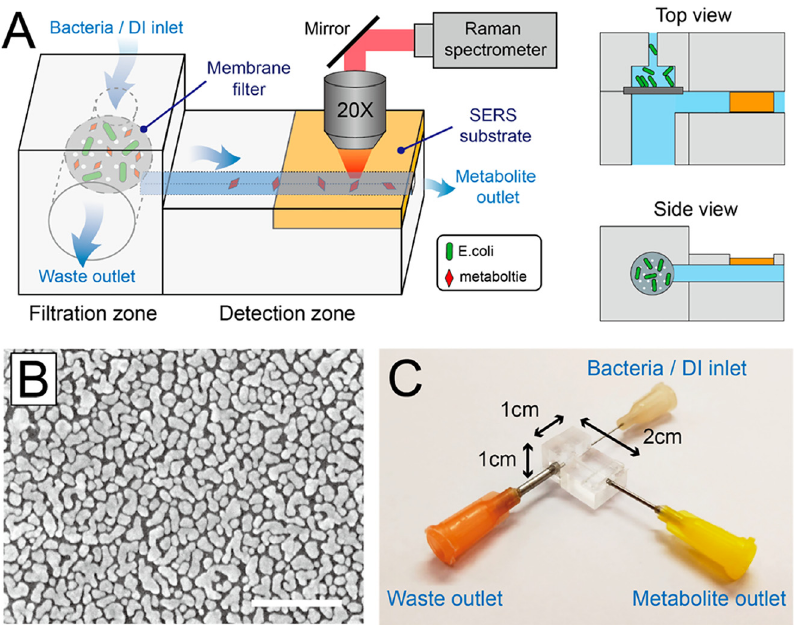
Figure 10: MF-SERS system: (A) Schematic diagram of the microfluidic system and device; (B) scanning electron microscopy (SEM) image of SERS substrate (scale bar, 200 nm); and (C) photo of the micro fl uidic device. Reprinted with permission from [64], Copyright (2019) American Chemical